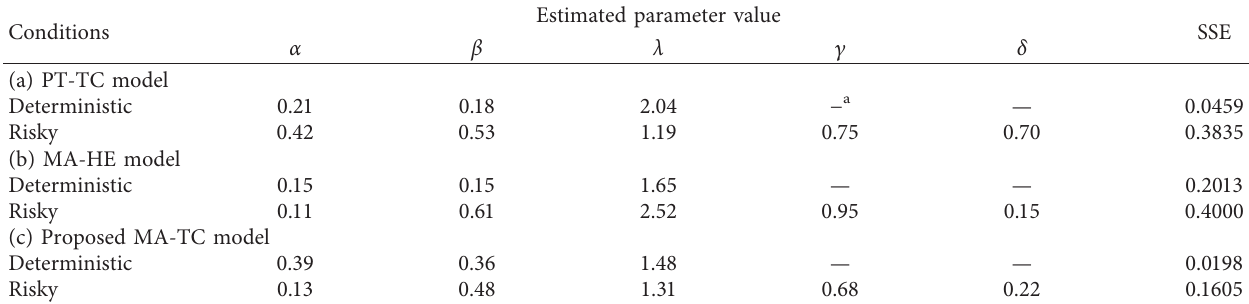
Table 5: Parameter calibration results of the PT-TC, MA-HE, and proposed models.